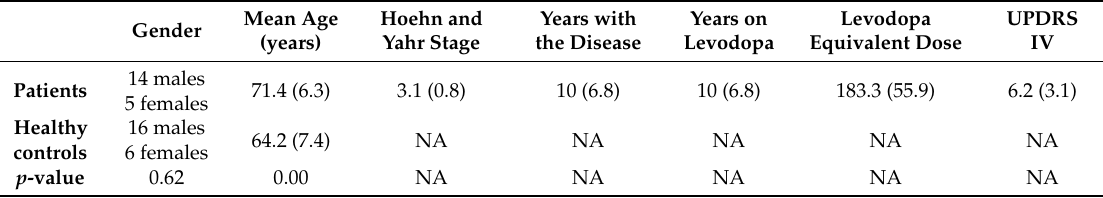
Table 1. Characteristics, mean (standard deviation) of patients and healthy subjects. UPDRS IV is the complications of therapy questions answered by patients regarding dyskinesias, clinical fluctuations and other complications. Mean Age